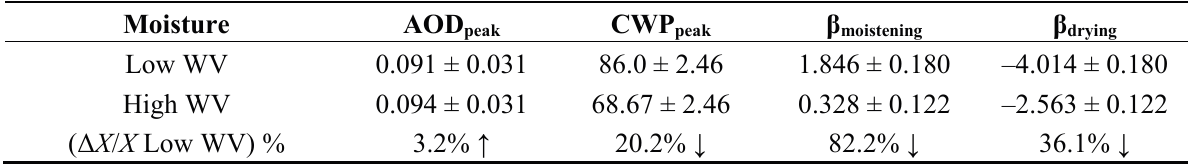
Figure 10. Response of cloud water path (CWP) to increasing aerosol optical depth (AOD) in low and high atmospheric water vapor (WV) environments for AADR_Urban. Table 4. Comparative table of percent increase ( ↑ ) or decrease ( ↓ ) in the characteristics parameters of cloud water path response curve aerosol induced perturbation from low to high water vapor environment